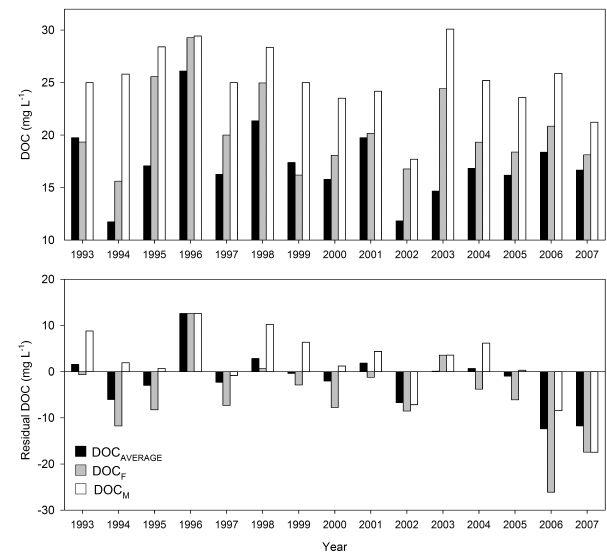
Fig. 4. The top panel show the inter-annual variation in DOC AVERAGE (Black bars), DOC F (Grey bars) and DOC M (White bars) and the lower panel show the residual DOC AVERAGE (Black bars), DOC F (Grey bars) and DOC M (White bars) after subtraction with the RIM modelled values. A positive residual DOC indicates high soil water DOC during spring inferred from stream DOC con- centrations, and vice